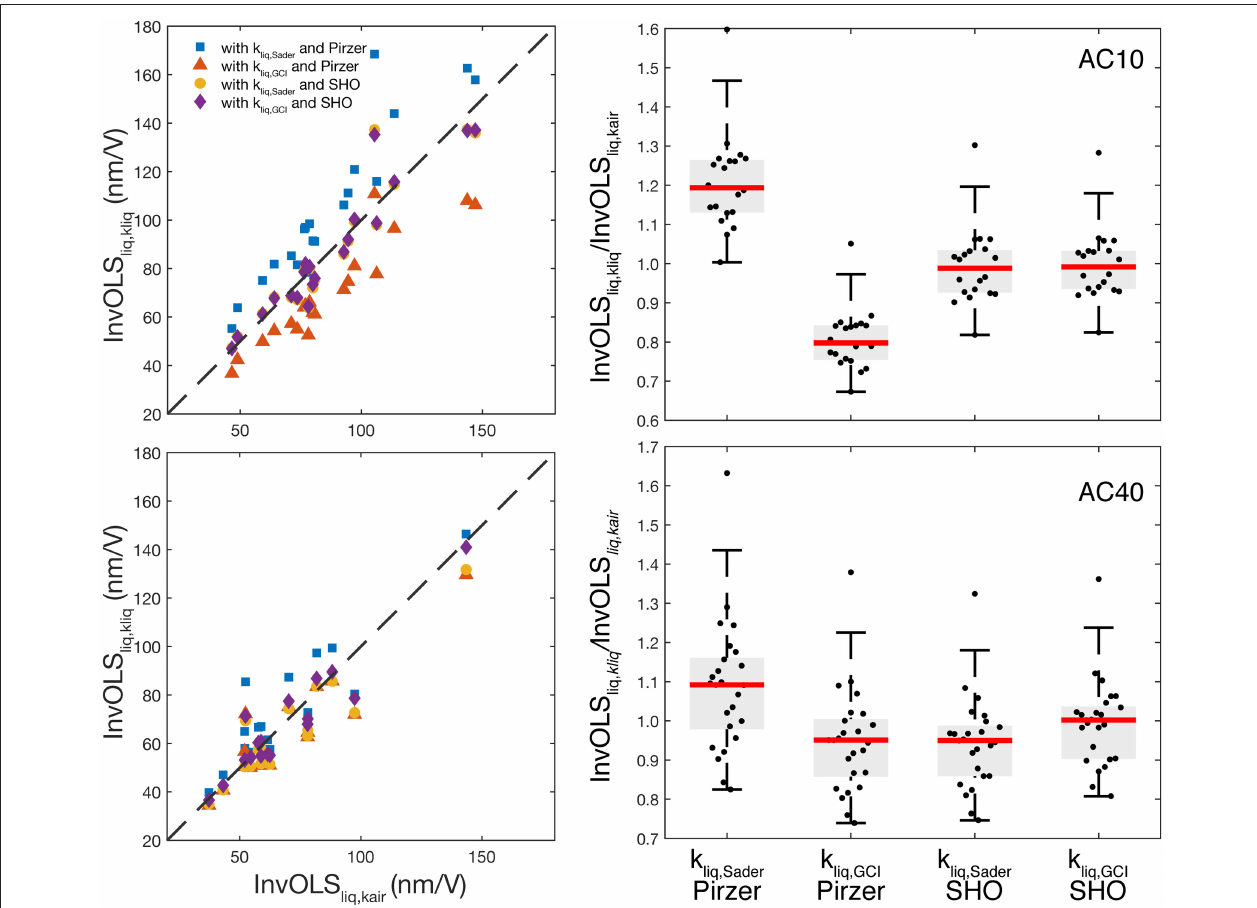
FIGURE 2 | (Left) Scatter plot showing the individual InvOLS liq values calculated using the different approaches and PSD models vs. the reference value InvOLS liq,kair for AC10 (top), and AC40 (bottom). (Right) Boxplot of the InvOLS values in liquid normalized by the InvOLS in liquid using k air , using either Sader and GCI calibration methods with either Pirzer and SHO models for AC10 (top) and AC40 (bottom). The red line is the median, the boxes show the 25th and 75th percentiles, and whiskers represent 2.7-times the standard